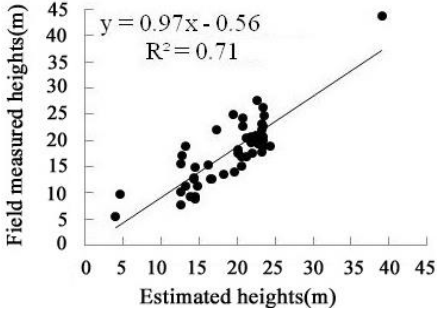
Figure 5. The validation results of the canopy heights ( n = 46).